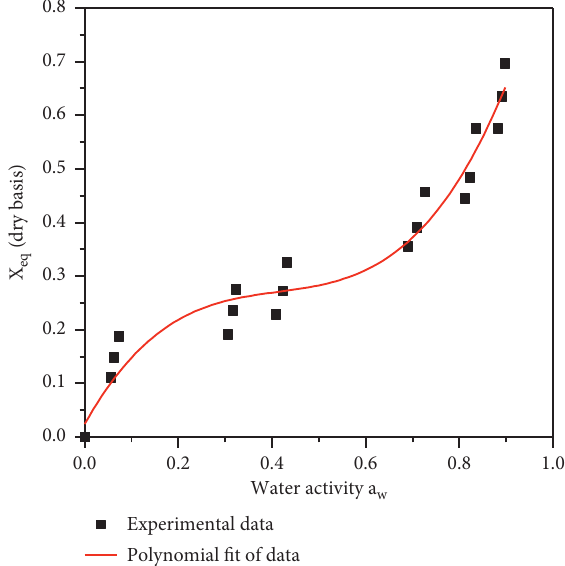
Figure 4: Optimal water activity for SCP